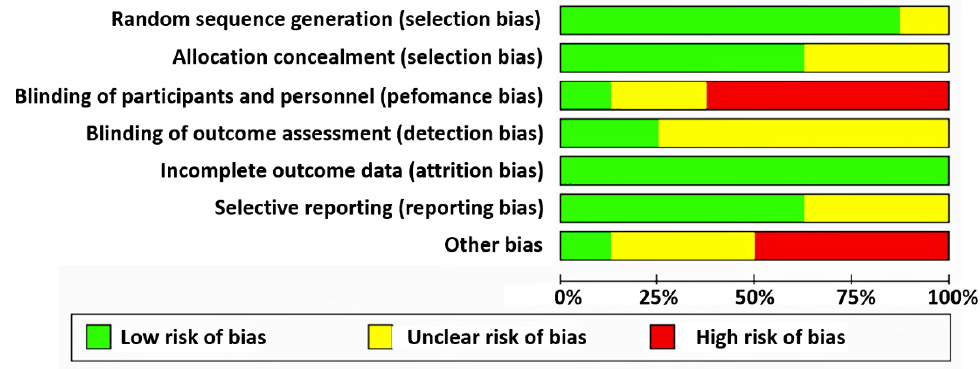
Figure 2. Risk of bias assessment summary.